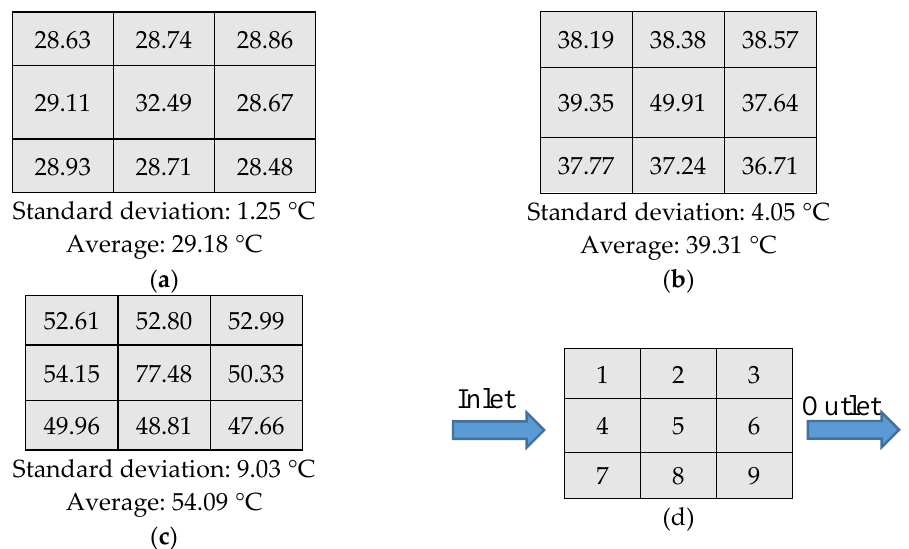
Figure 15. The heat source temperature uniformity for 3-layers MLM heat sink of 30 mL/min HTF flow rate for a power rate of ( a ) 5 W, ( b ) 15 W and ( c ) 30 W; ( d ) Schematic of the thermocouple distribution on heat source surface.